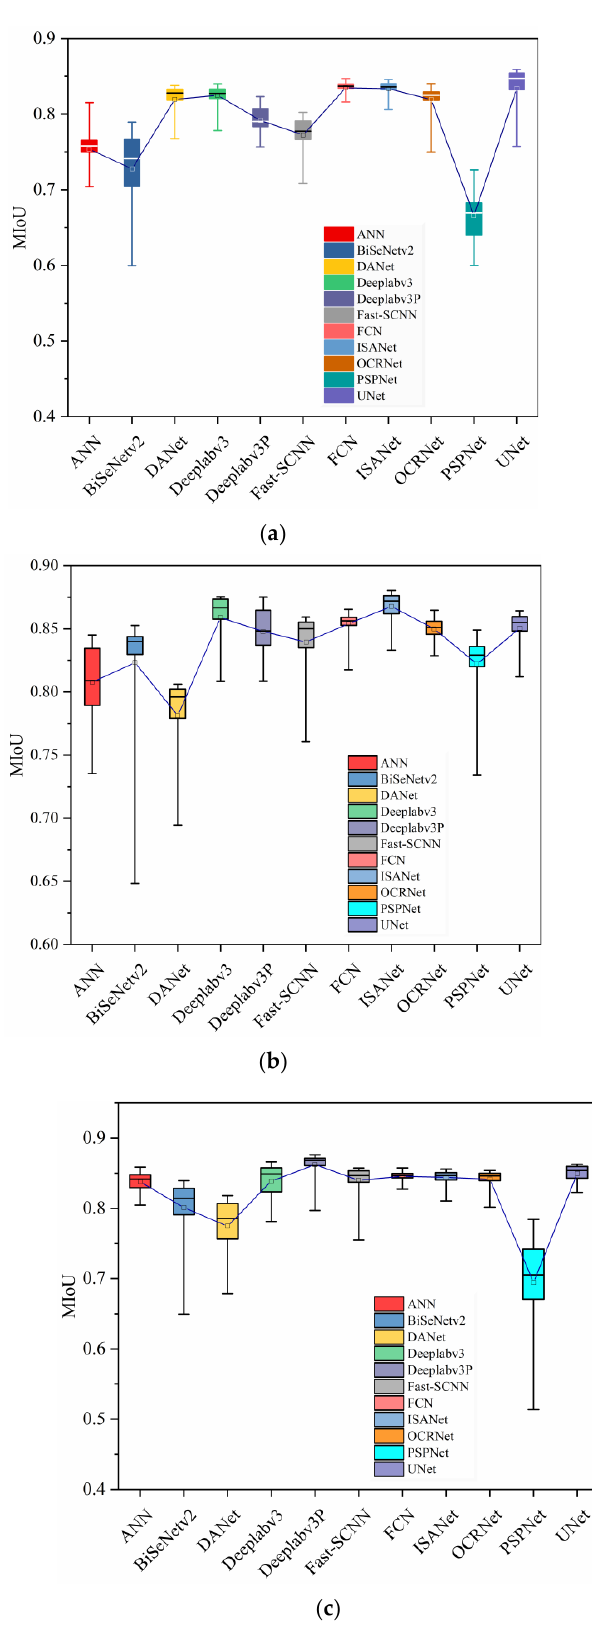
Figure 13. MIoU values of 11 models on the three types of datasets: ( a ) left eye, ( b ) right eye, and ( c ) left and right eyes.